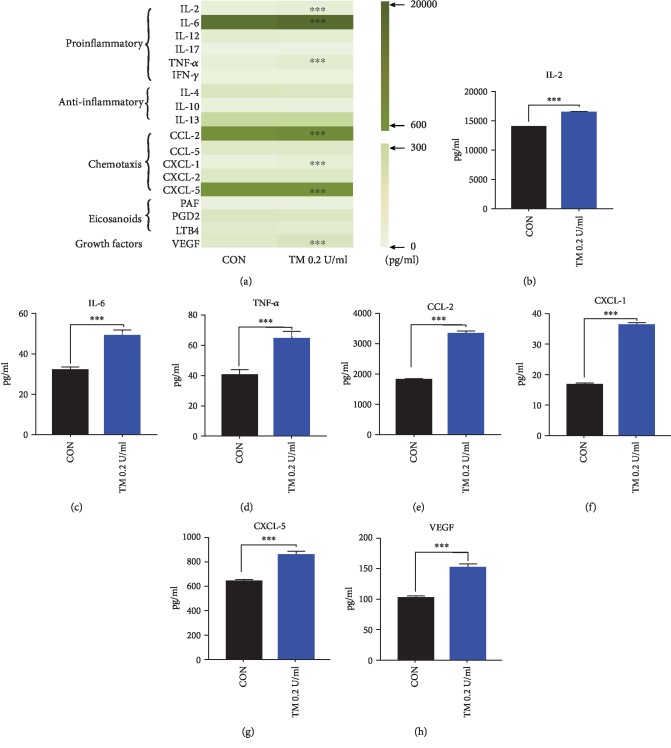
Effect of 0.2 U/ml thrombin on mediators' secretion from P815 cells. Compared with the control group, it is significantly increased in the level of IL-2 (b), IL-6 (c), TNF-α (d), CCL-2 (e), CXCL-1 (f), CXCL-5 (g), and VEGF (h) in supernatants after 16 h incubation with 0.2 U/ml thrombin. (a) Results of stimulation by 0.2 U/ml thrombin; data which are shown by the average outcome came from three independent trials. CON: control group; TM: thrombin. Each experiment was performed three times. Unpaired t-test was used to test the statistic difference between the control and trial groups; P < 0.05 was considered statistically different.